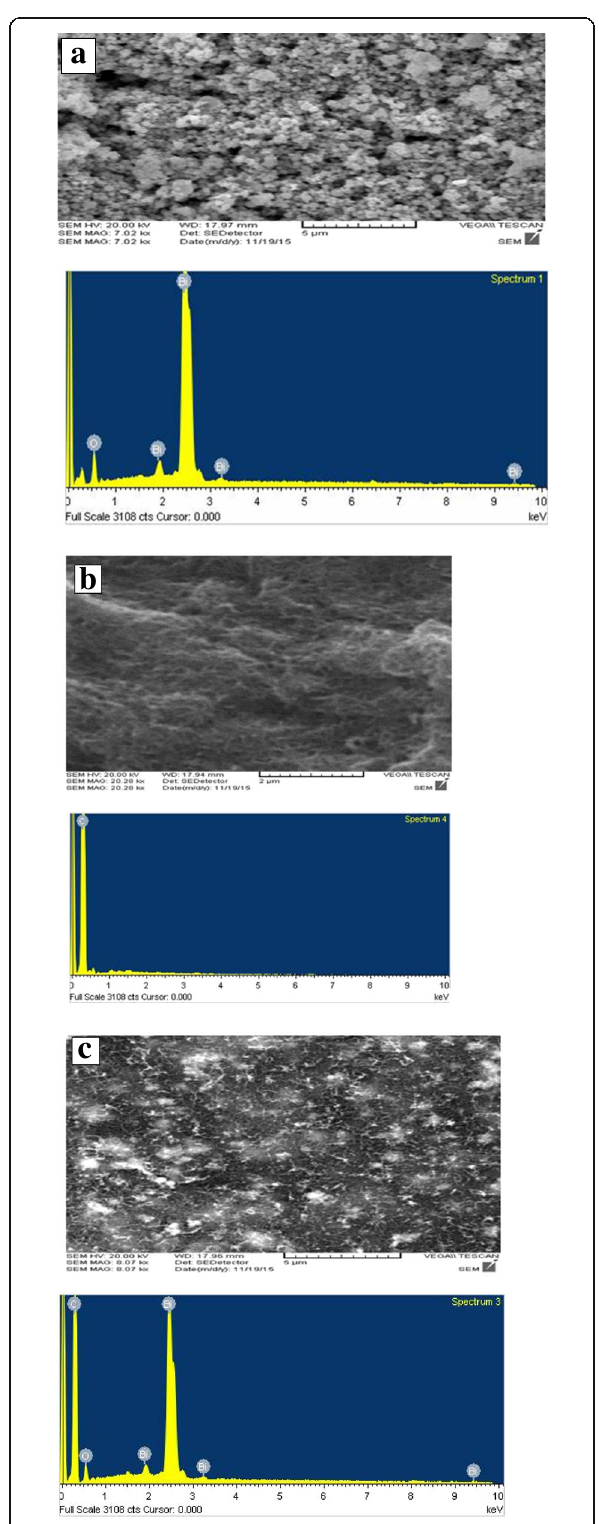
Fig. 1 SEM-EDS images of a Bi 2 O 3 nanoparticles, b MWCNTs, and c Bi 2 O 3 /MWCNT